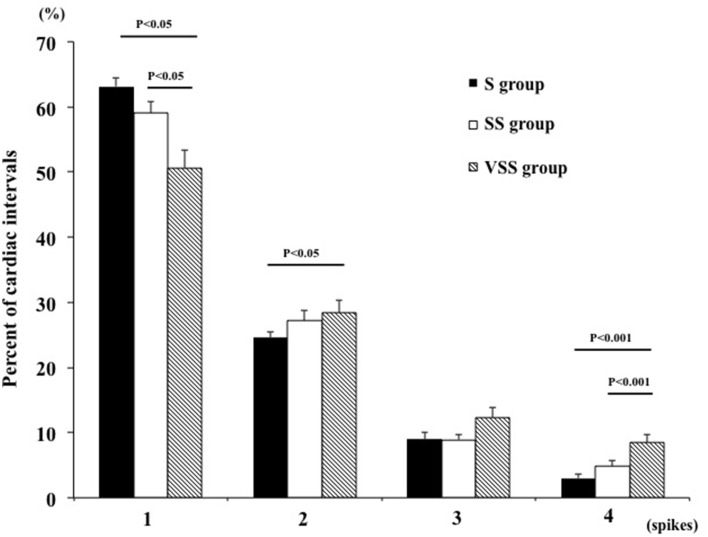
Percentages of cardiac intervals in which one, two, three, or four single-unit spikes were calculated separately. In the VSS group, there was a significant decrease in the percentage of cardiac intervals that contained one spike compared with the other groups, and a significant increase was observed in the proportion of cardiac intervals that had four spikes compared with the other groups. There were no statistical differences in the firing properties of the S and SS groups. S group, AHI of 5–30 events/h; SS group, AHI of 30–55 events/h; VSS group, AHI of >55 events/h. AHI, apnea-hypopnea index.